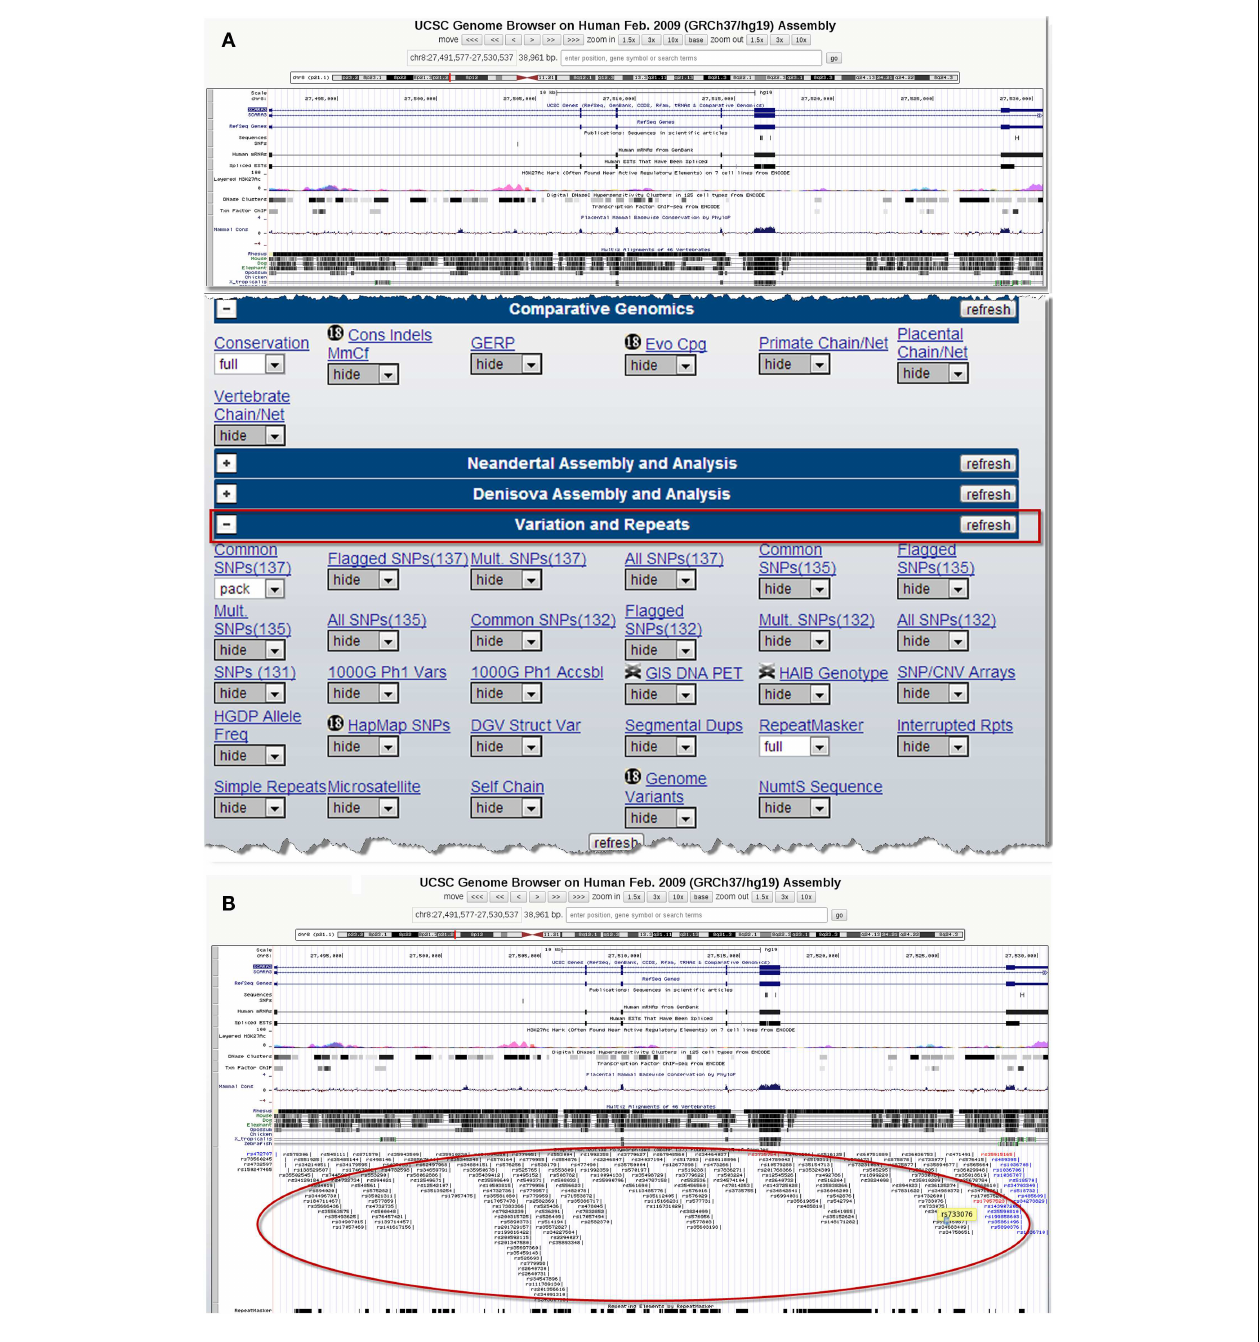
Under the “ Variation and Repeats ” tab, selecting “ pack ” under the “ Common SNPs ” option updates the output to include a full display of SNPs represented by their refSNP cluster ID numbers [ (B) , circled]. Clicking on any of the refSNP cluster IDs leads to a link displaying further information regarding the SNP as well as a link to NCBI’s dbSNP database.